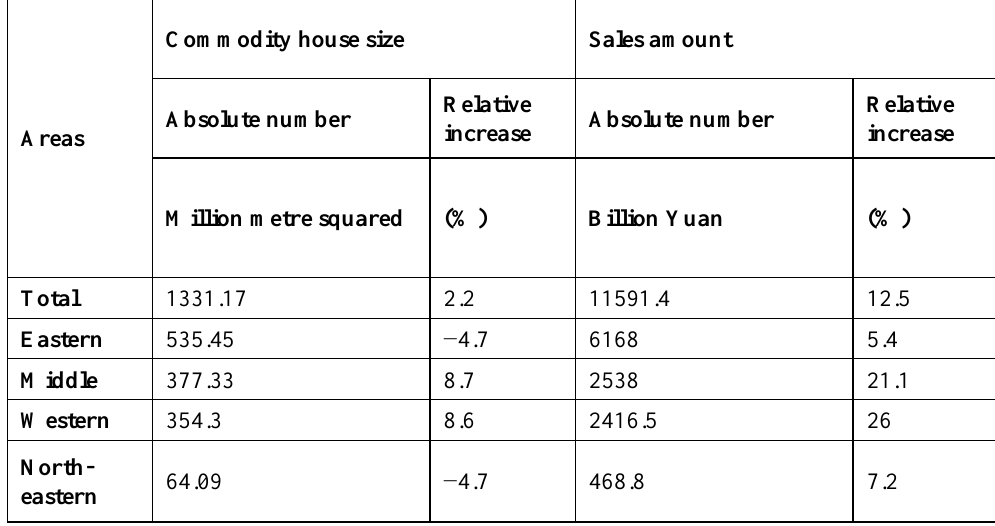
Table 3. The Size and Sales of Real Estate across China from Jan. to Oct. 2018 ( National Bureau of Statistics of China, 2018 ) Commodity house size Sales